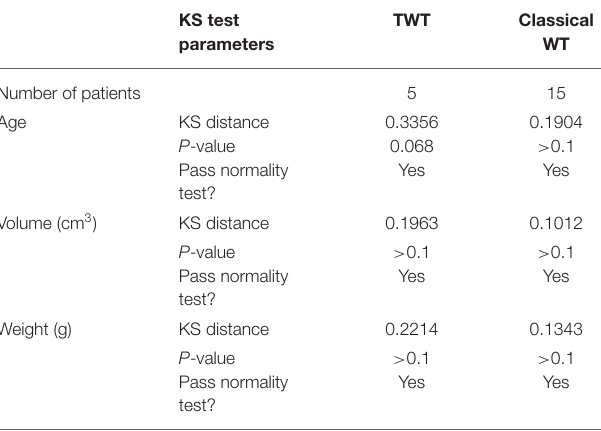
TABLE 3 | Normality tests for quantitative data by Kolmogorov-Smirnov